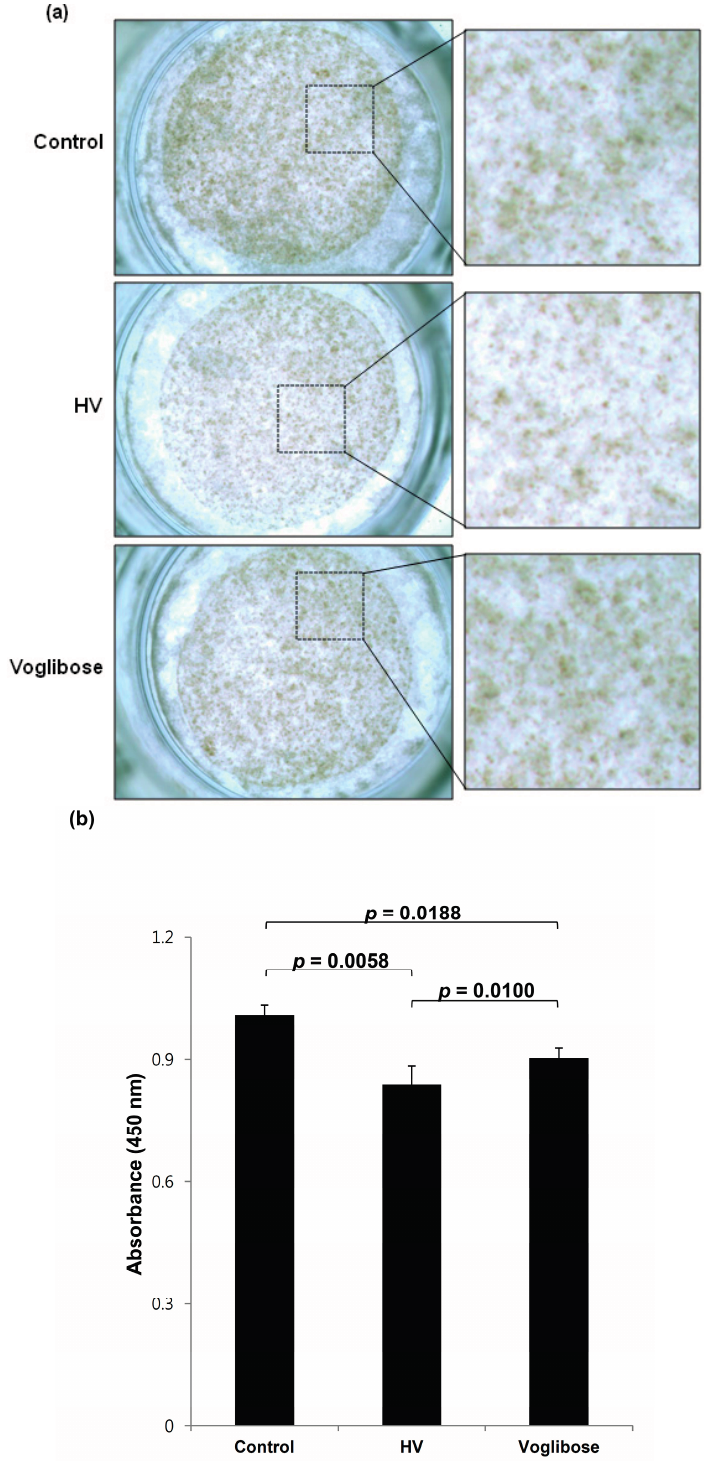
Figure 2. The inhibitory effect of HV on melanin production in a reconstructed human skin model. ( a ) The reconstructed human skin samples were irradiated with 20 mJ/cm 2 ultraviolet B (UVB) every other day for a total of four exposures and simultaneously treated with 2 mM HV or voglibose for 10 days. Each representative image was obtained after treatment. The insets show the magnified images; ( b ) The melanin content of the lysates was measured at 450 nm after dissolving the reconstructed human skin samples in 1 N NaOH. Data are shown as mean ± SEM ( n =